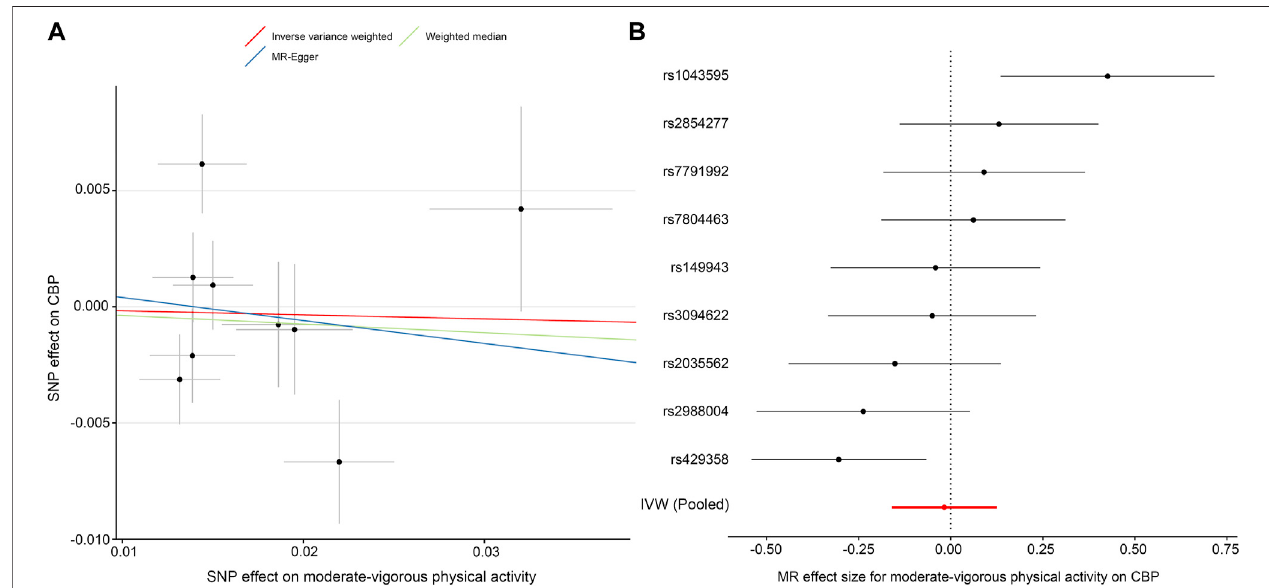
FIGURE 2 | MR plots for the effect of moderate-vigorous physical activity on chronic back pain (CBP). (A) Scatter plot of the SNP effect on moderate-vigorous physical activity vs. that on CBP. The slope of each fi tted line represents the pooled MR effect calculated by each method. (B) Forest plot of individual and pooled MR